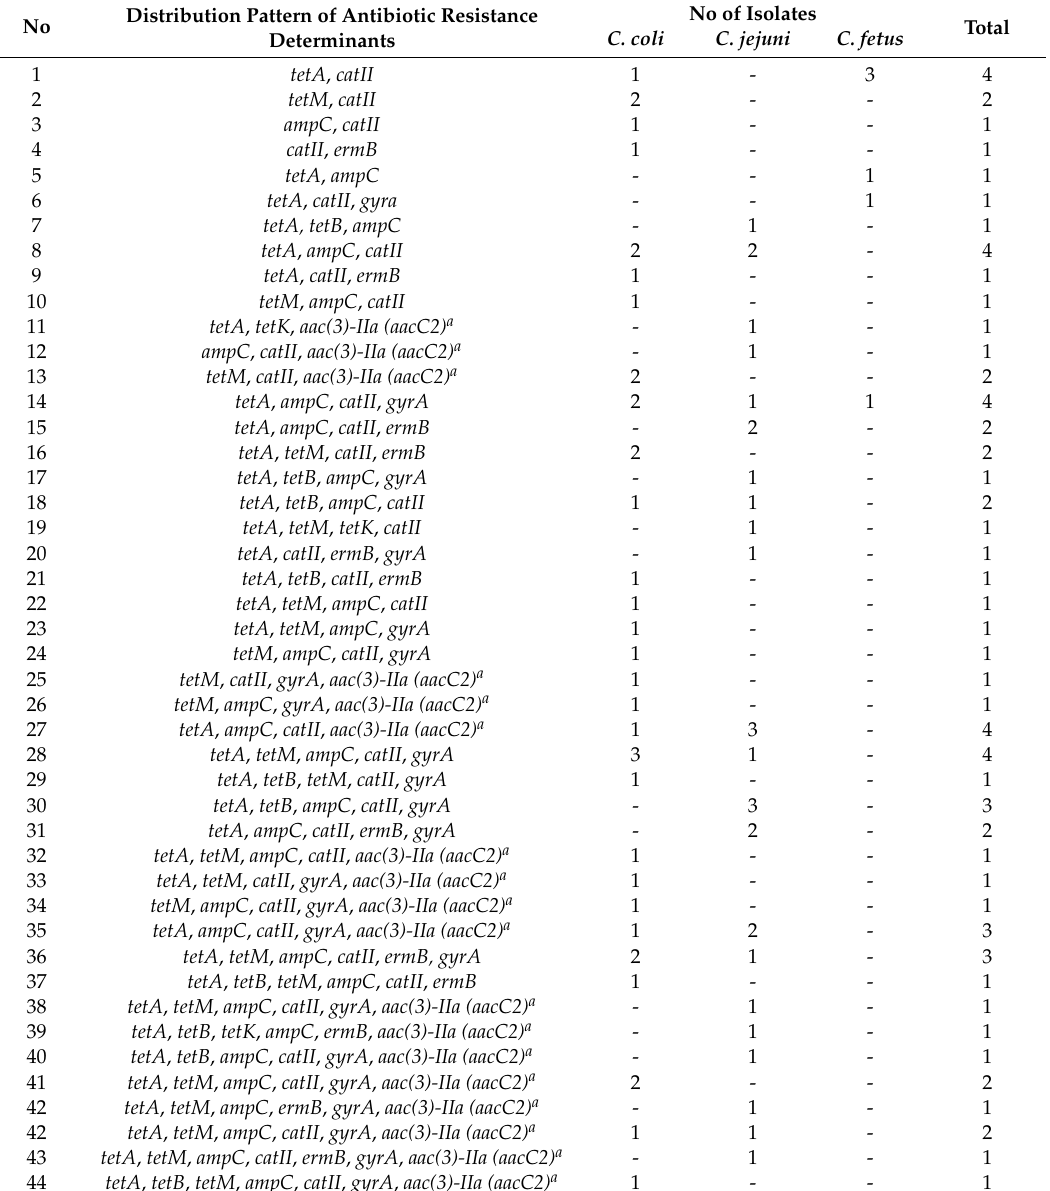
Figure 9. Gel image of the PCR-confirmed catll gene. Lane M: DNA ladder (100 bp); lane 1: negative control; and lanes 2–9, Campylobacter isolates that harboured the catll gene (543 bp). Table 6. Distribution and pattern of multiple antibiotic resistance of Campylobacter species isolated from meat carcasses.